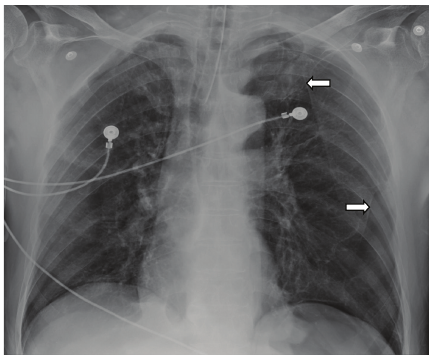
Figure 1: Anteroposterior chest X-ray following endotracheal tube placement showing hyperinflated lungs with multiple areas of hyperlucency on the left lung base and left apex, surrounded by a thin linear demarcation (arrows).